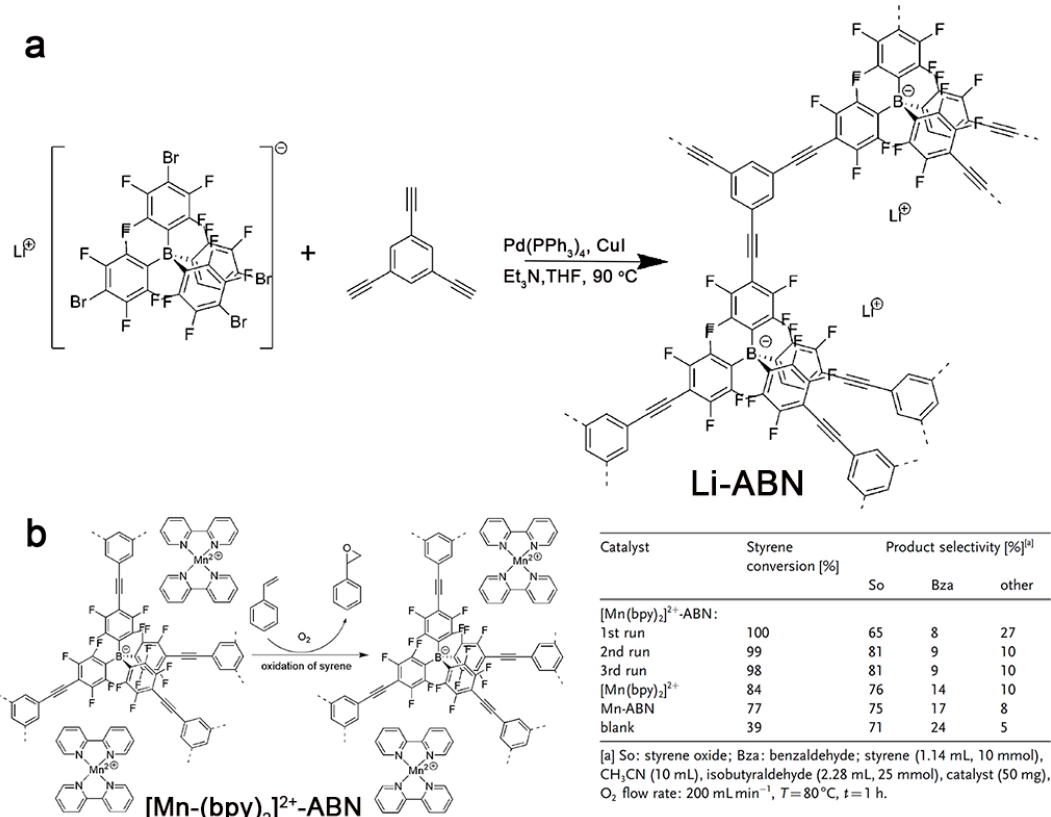
Figure 8. A synthesis route of Li-ABN ( a ); structural illustration of [Mn-(bpy) 2 ] 2+ -ABN and its catalysis performance of styrene oxidation ( b ). Reprinted with permission from [93]. Copyright 2013, Wiley-VCH.